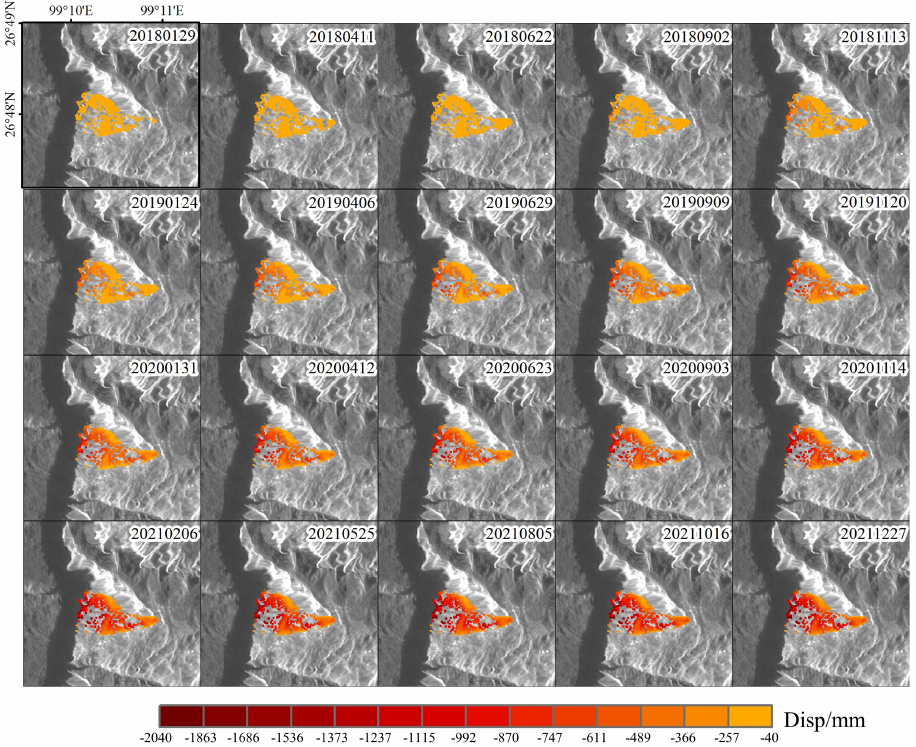
Figure 11. Time − series cumulative deformation calculated from 5 January 2018 of the landslide on each acquisition date. The base map is the SAR intensity average image, and the dates are labeled on the top right corner of every